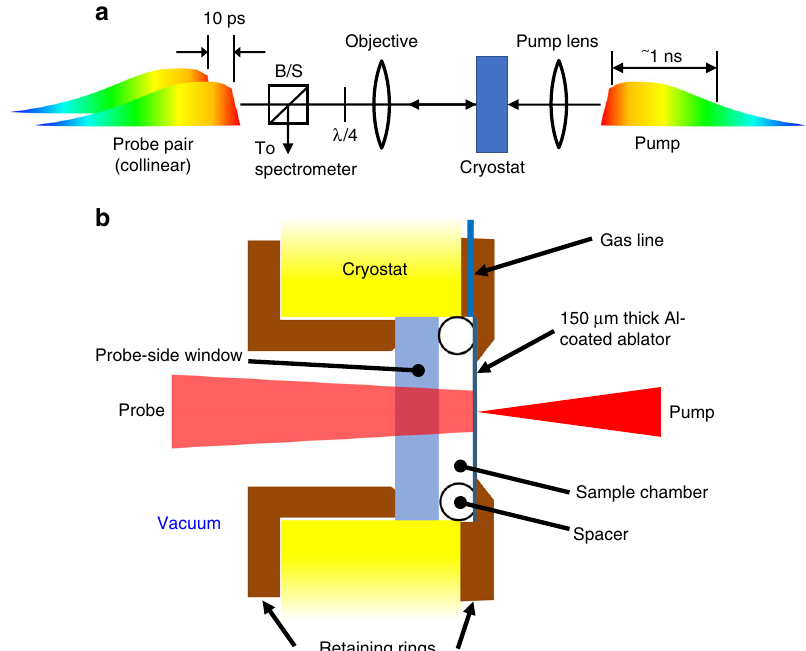
Fig. 1 Schematic of the experimental setup. a A focused ≈ 1 ns duration pump impinges from the right, while a pair of similar duration low energy pulses from the left characterize the shocked state. The re fl ected probes are phase-shifted by a shock wave in the sample, and the phase shift is measured via spectral interferometry, providing wave speeds. B/S is a polarizing beam splitter, and λ /4 is a quarter waveplate set to rotate the polarization by 90 degrees in double pass. b Close-up of the sample, where the focused ( ≈ 50 µ m diameter) laser pulse drives a shock-wave into the Al ablator. The shock-wave propagates through the ablator and then compresses a small region ( ≈ 10 4 µ m 3 ) of the cryogenic LCO sample; the volume of the whole sample is ≈ 1 cm 3 .